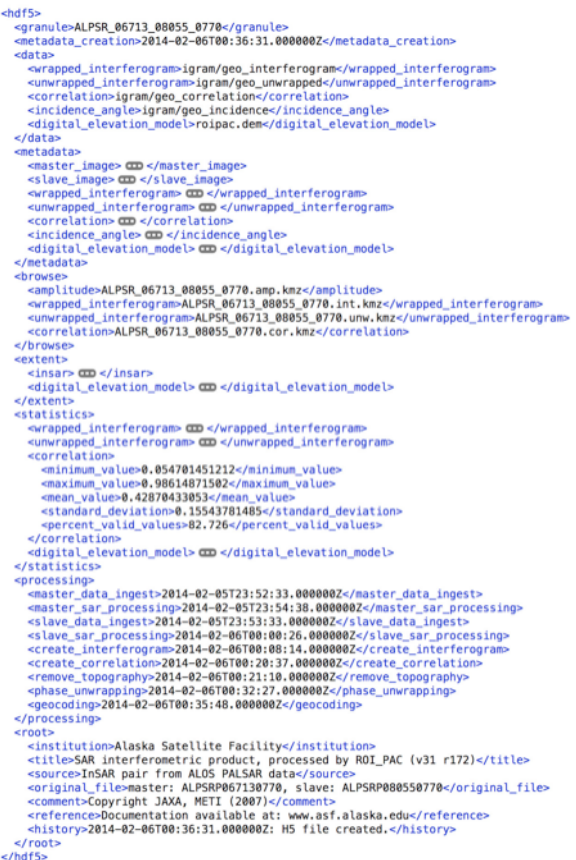
Figure 9. Example of XML metadata file used to generate ISO compliant metadata .